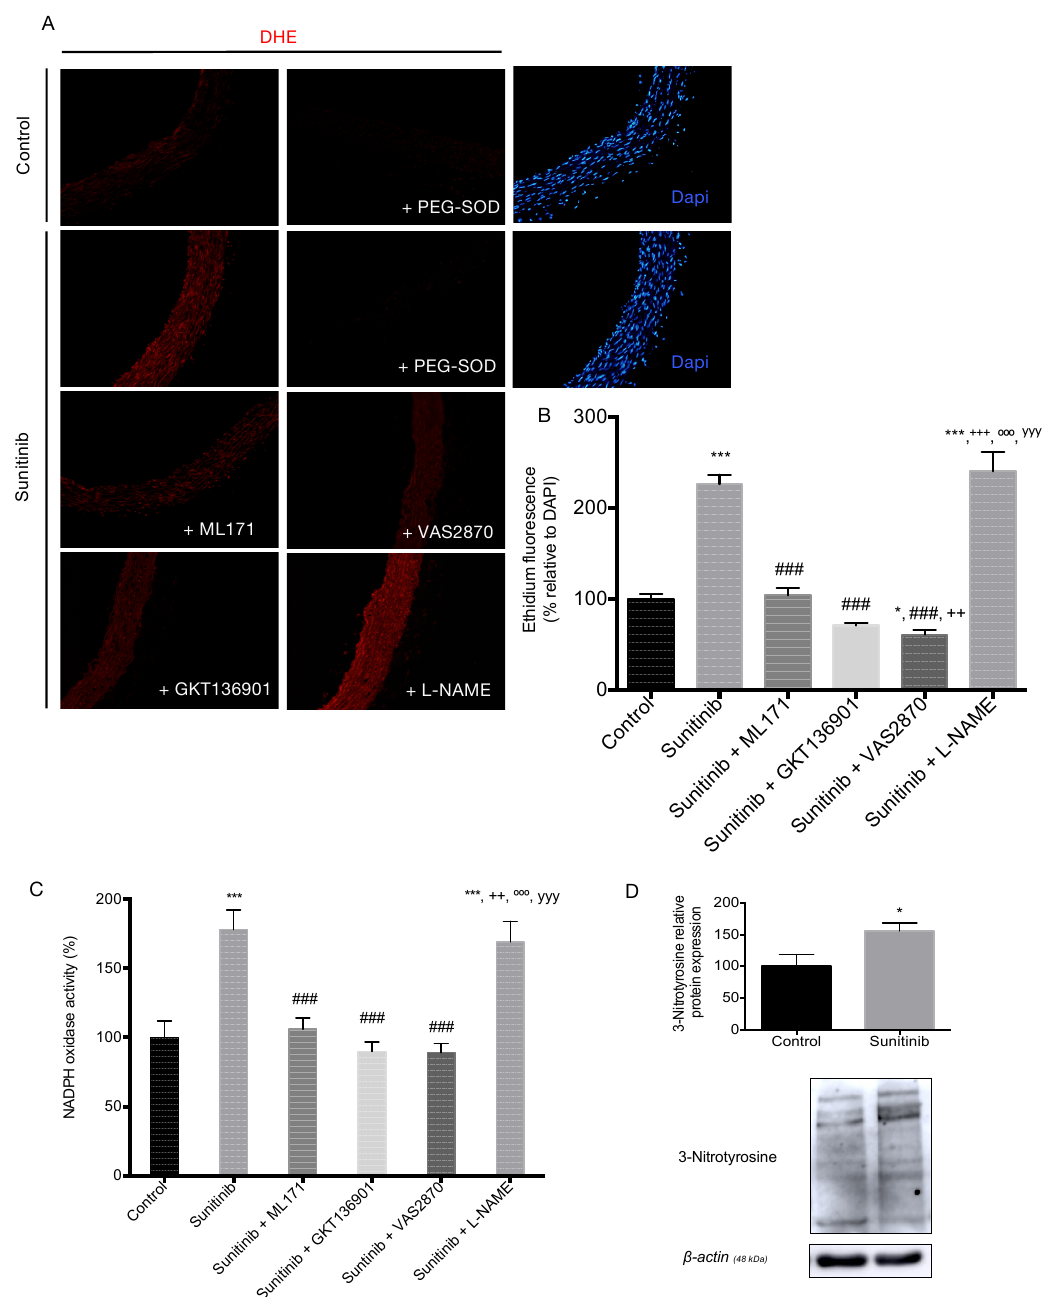
Figure 5. Superoxide anion production in thoracic aortas. ( A ) Representative dihydroethidium (DHE) staining, ( B ) superoxide anion quantification, ( C ) NADPH oxidase activity in aorta homogenates, and ( D ) 3-nitrotyrosine protein expression, in aortas from control and sunitinib-treated (25 mg / kg / day) animals. Magnification: 10 × . Values are expressed as mean ± S.E.M. of at least four animals per group ( n = 4–8). * p < 0.05, *** p < 0.001 vs. control group; ## p < 0.01, ### p < 0.001 vs. Su group; ++ p < 0.01, +++ p < 0.001 vs. Su + ML171 group; ººº p < 0.001 vs. Su + GKT136901 group; yyy p < 0.001 vs. Su + VAS2870